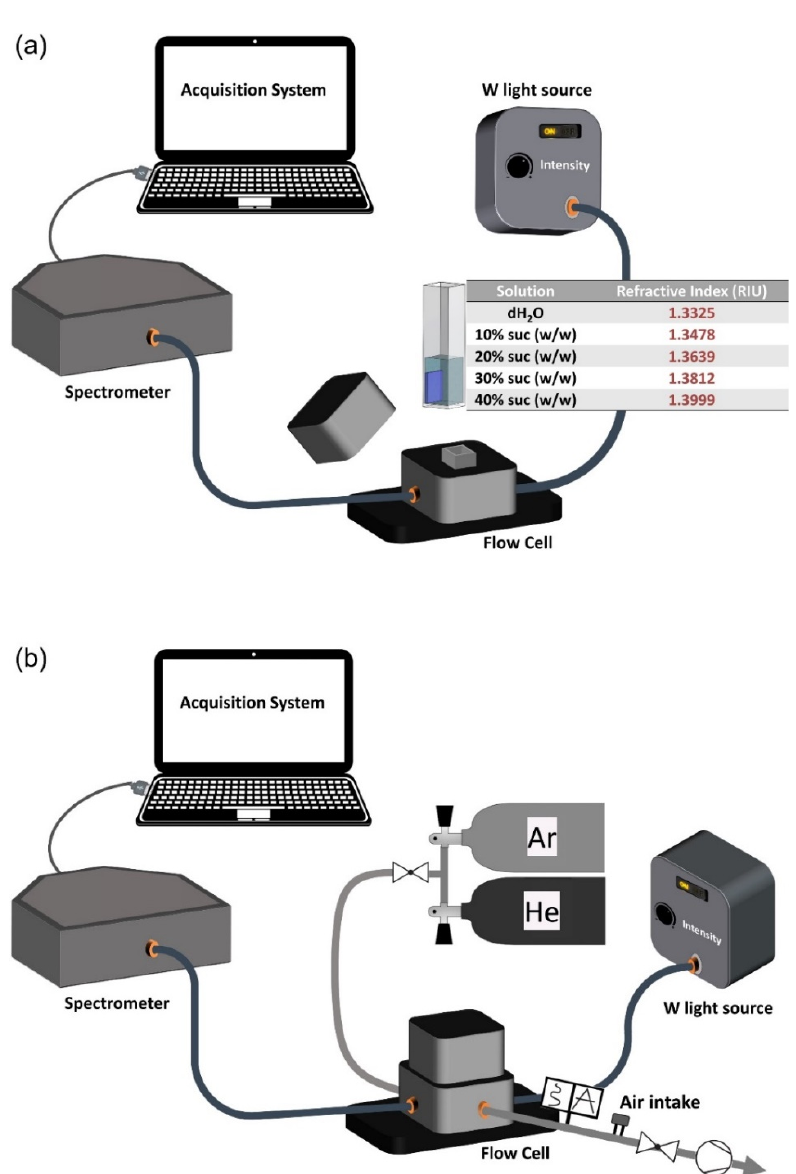
Figure 2. Schematic representation of experimental setup for HR-LSPR sensing, adapted to the liquid ( a ) and gas ( b ) experimental procedure.